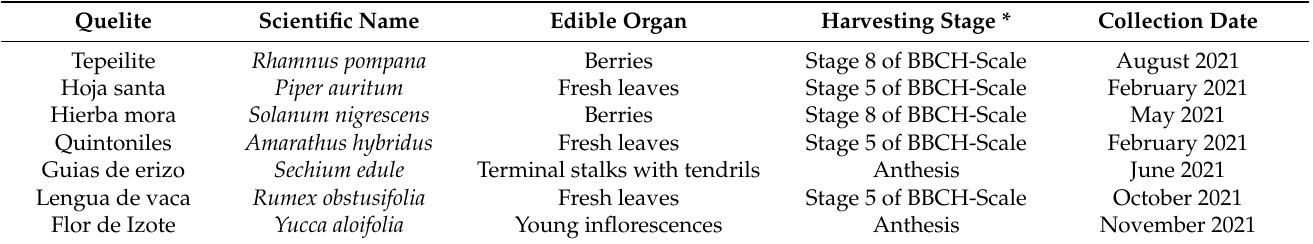
Table 1. Edible quelites consumed in the northern highlands of Puebla-M é xico.